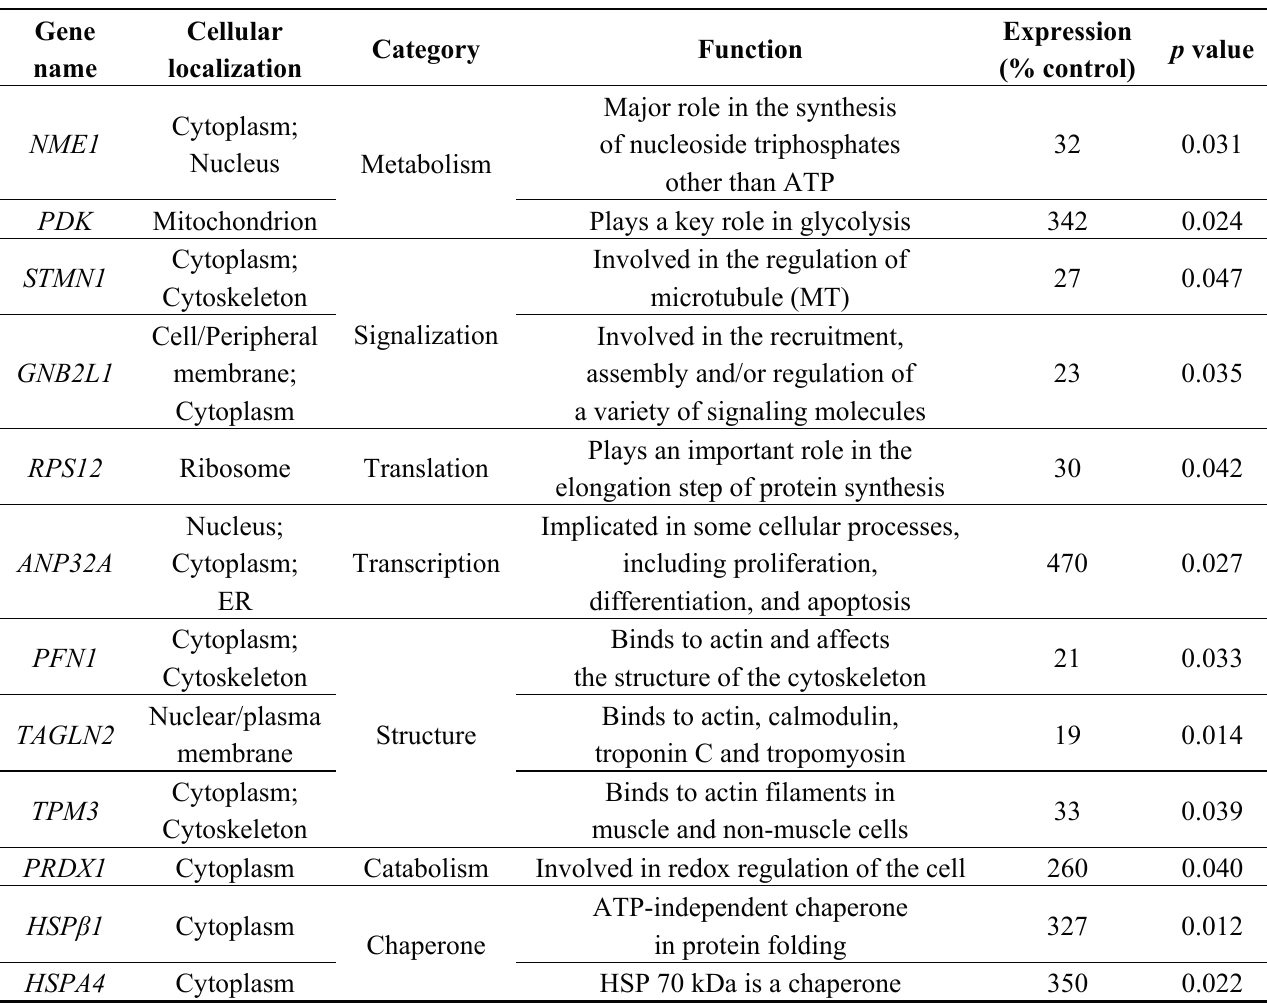
Table 2. Densitometry analysis of differentially expressed proteins in the atrazine-treated and control MCF-10A cells. The up- or down-regulated proteins were expressed as % of